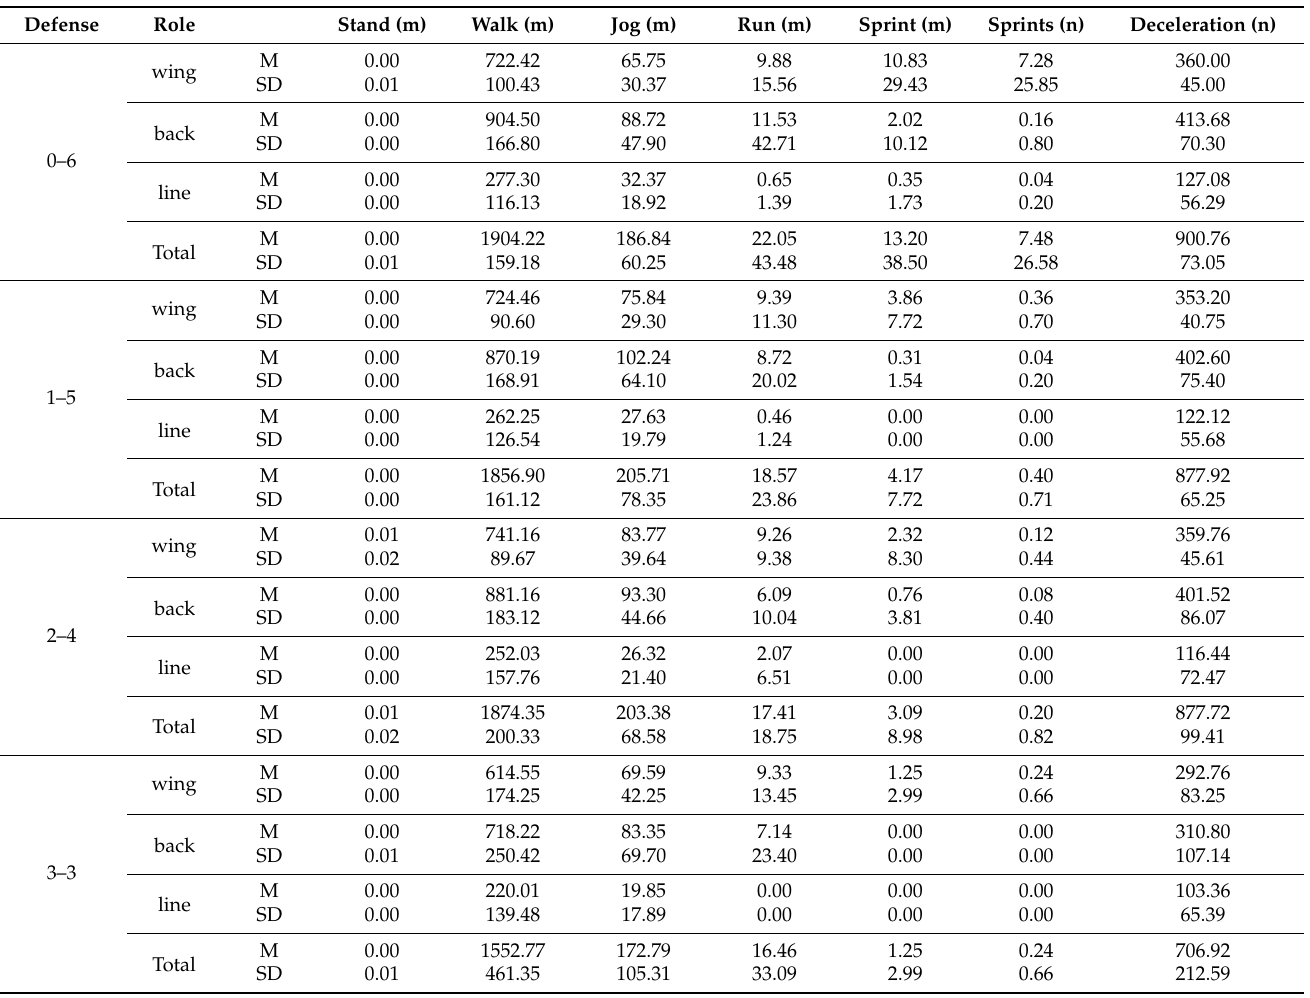
Table 1. Mean ± SD physical demands intention as a function of defensive organization and players’ role, normalized per 10-min of play.